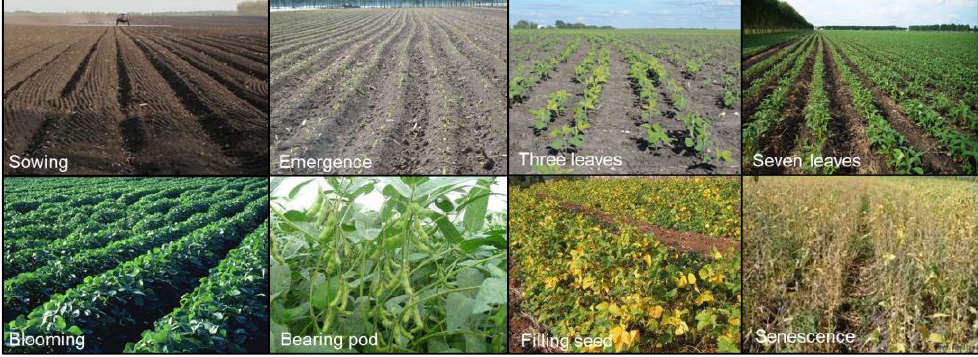
Figure 2. Key phenological events of soybean cultivation in Heilongjiang Province.